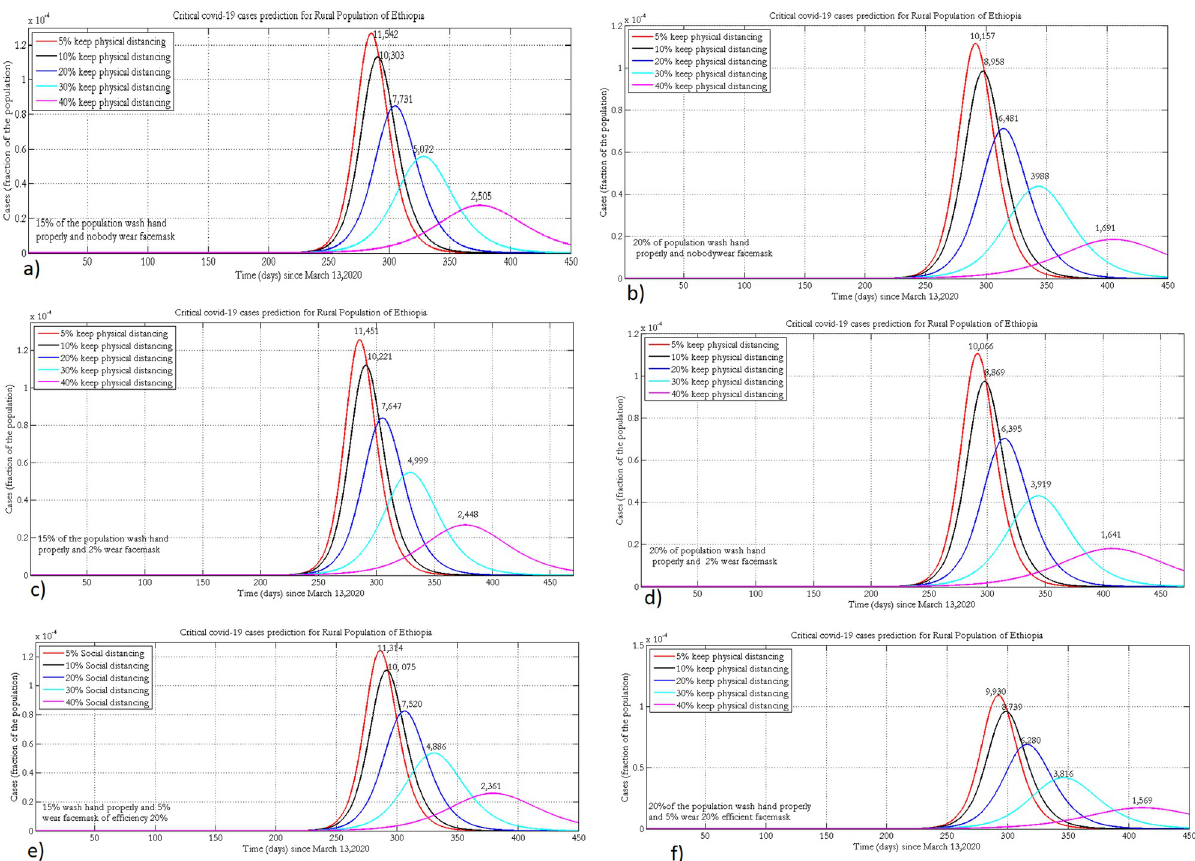
Fig 7. Projection of intensive care or critical cases in the rural population of Ethiopia when 15% or 20% practice hand washing and 0% (a, b), 2% (c, d) or 5% (e, f) of the population wear face masks, with 20% efficacy.